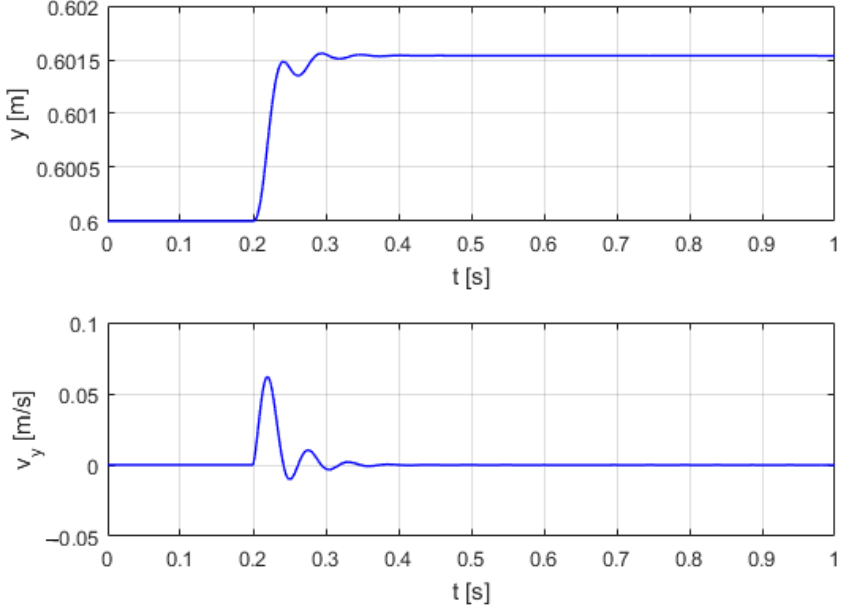
Figure 11. Dynamic responses of the displacement y ( t ) and speed v y ( t ) of an undamped SHA.